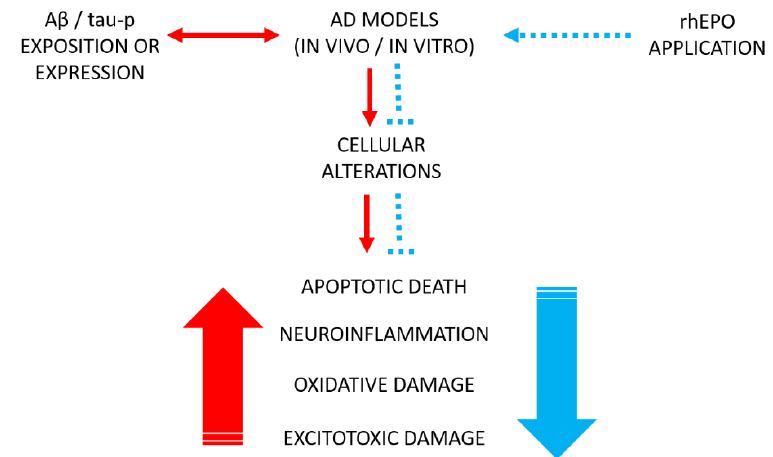
Figure 3. rhEPO effects on cell damage in AD models. The rhEPO application as a pharmacological treatment (blue dotted arrow) diminishes cellular alterations (blue dotted lines) generated in response to exposition or expression to A β or tau-p proteins in vitro and in vivo AD models (double-head red arrow). Red big arrow refer to increased cellular alterations, while blue big arrow refer to damage inhibition.